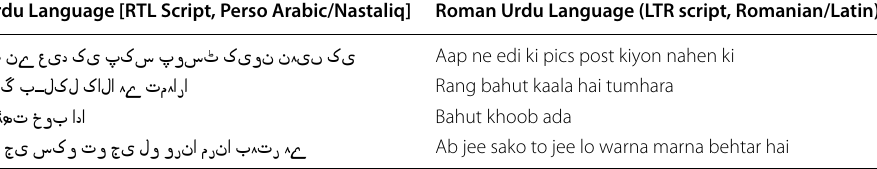
Table 1 Example script of Urdu and Roman Urdu